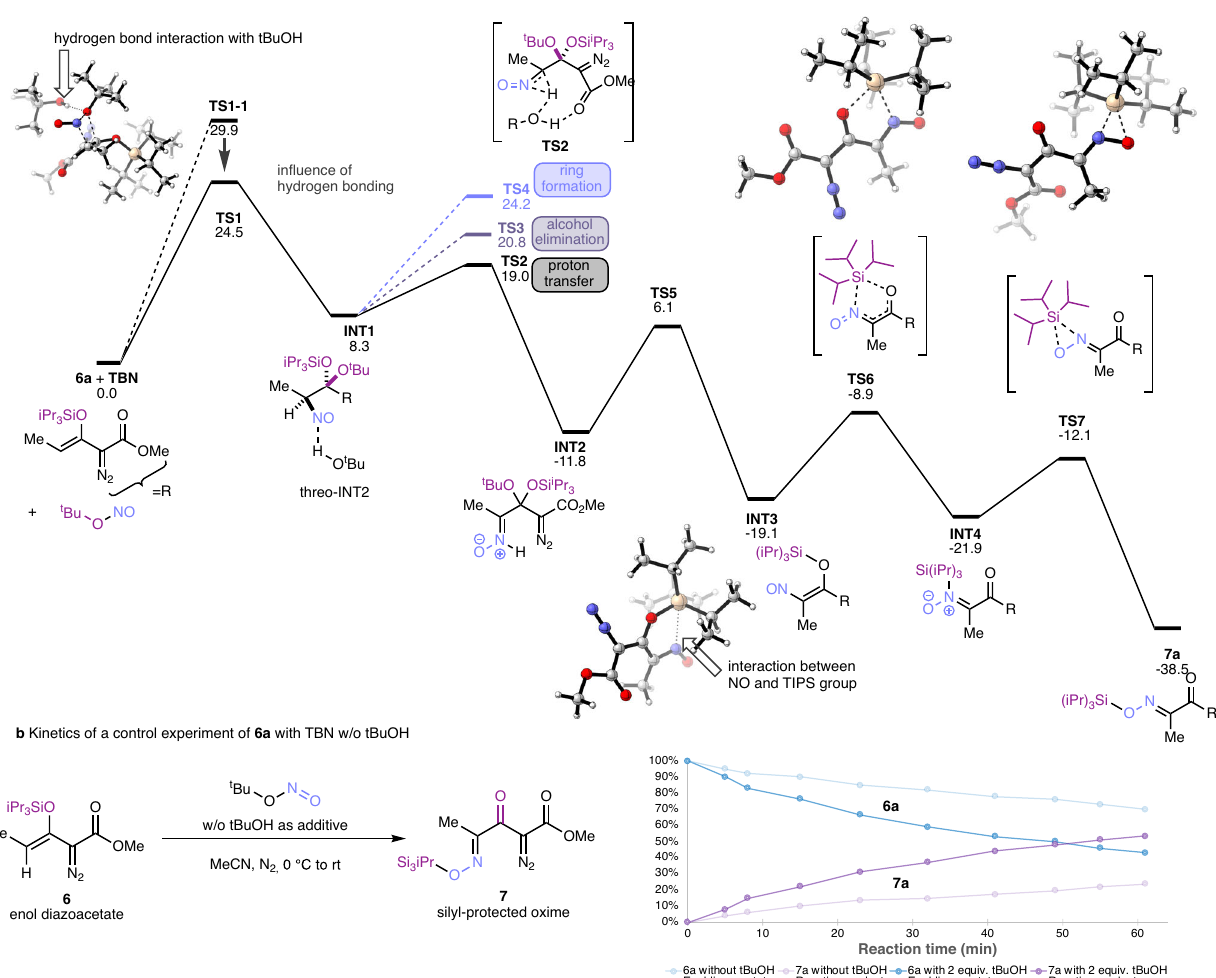
Fig. 3 | Computational studies on the reaction mechanism. a Calculated reaction mechanism. b Reaction